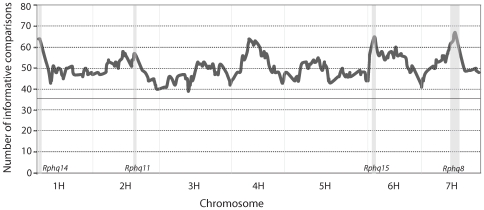
Number of informative comparisons across the barley genome based on a distant-pair design (see text) with extra weight given to four pQTL regions (shown as grey blocks).The solid horizontal line at 36 represents the average number of informative comparisons when samples were randomly paired.